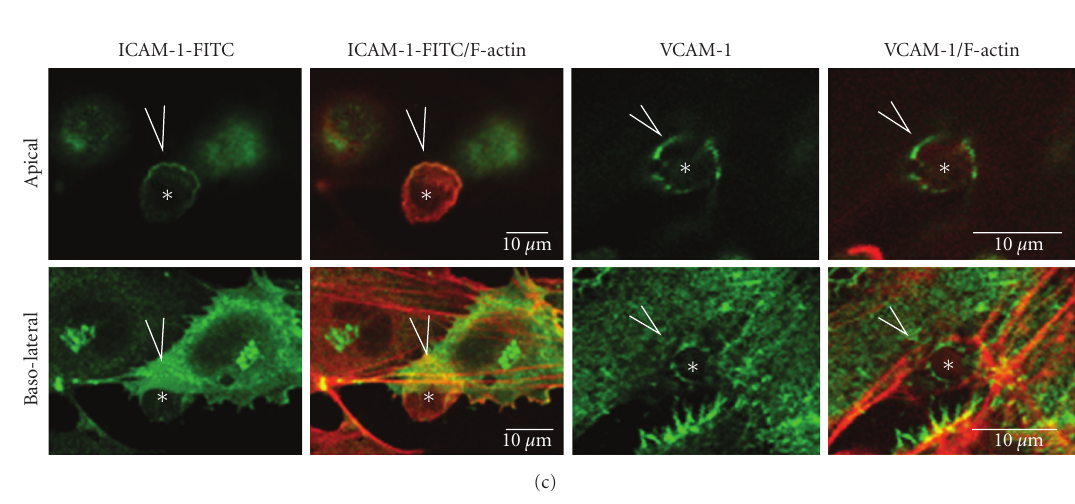
Figure 1: ICAM-1 and VCAM-1 localization in TNF α -stimulated endothelial cells. (a) TNF α -treated HUVECs were fixed and stained as indicated. Bar, 20 μ m. (b) Detailed analysis of ICAM-1 and VCAM-1 co-localization at the apical surface (arrowheads) in TNF α -treated endothelial cells that were fixed and stained as indicated. Bar, 10 μ m. (c) Di ff erentiated HL60 cells were allowed to adhere to TNF α - treated HUVECs for 30 minutes, after which cells were fixed and stained as indicated. Apical focal plane shows that ICAM-1 and VCAM-1 (arrowheads) are recruited around adhered HL60 cells (asterisks). Bar, 10 μ